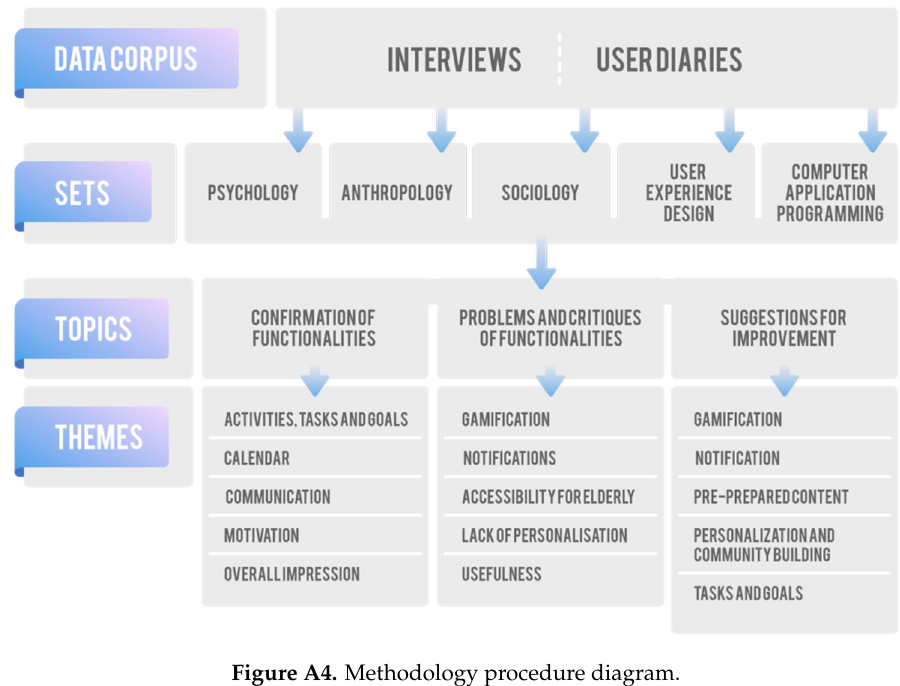
Figure A4. Methodology procedure diagram.